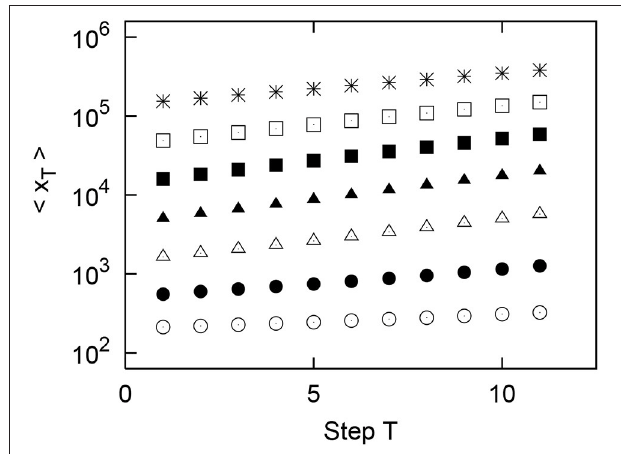
FIGURE 11 | Results of simulation of the growth of the geometric mean of the urban population using values randomly sampled from real data in the United States. Original ( T = 1) populations x 1 are divided into logarithmically equally sized bins: x 1 ∈ [10 0.5( m − 1) + 2 ,10 0.5 m + 2 ) ( m = 1,2, ··· ,7). Points in the figure indicate m = 1,2, ··· ,7 in order from the